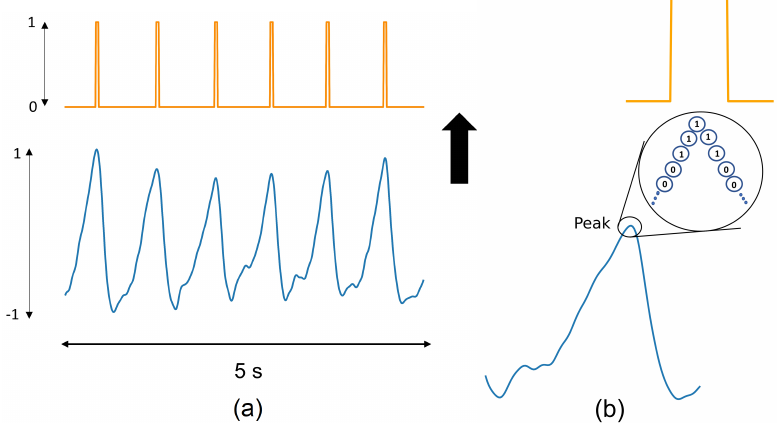
Figure 4. Schematic of labeling for PPG signal. ( a ) A 5 s PPG signal and its labeling vector; “1” indicates the peak’s location. ( b ) Five labels are set to “1” for each peak. Clean PPG signal selection: A 15 s window of clean PPG signal ( X ) is randomly selected. Noise selection: A 15 s window of noise ( N ) is randomly selected. Note that our noise dataset includes baseline wander and motion